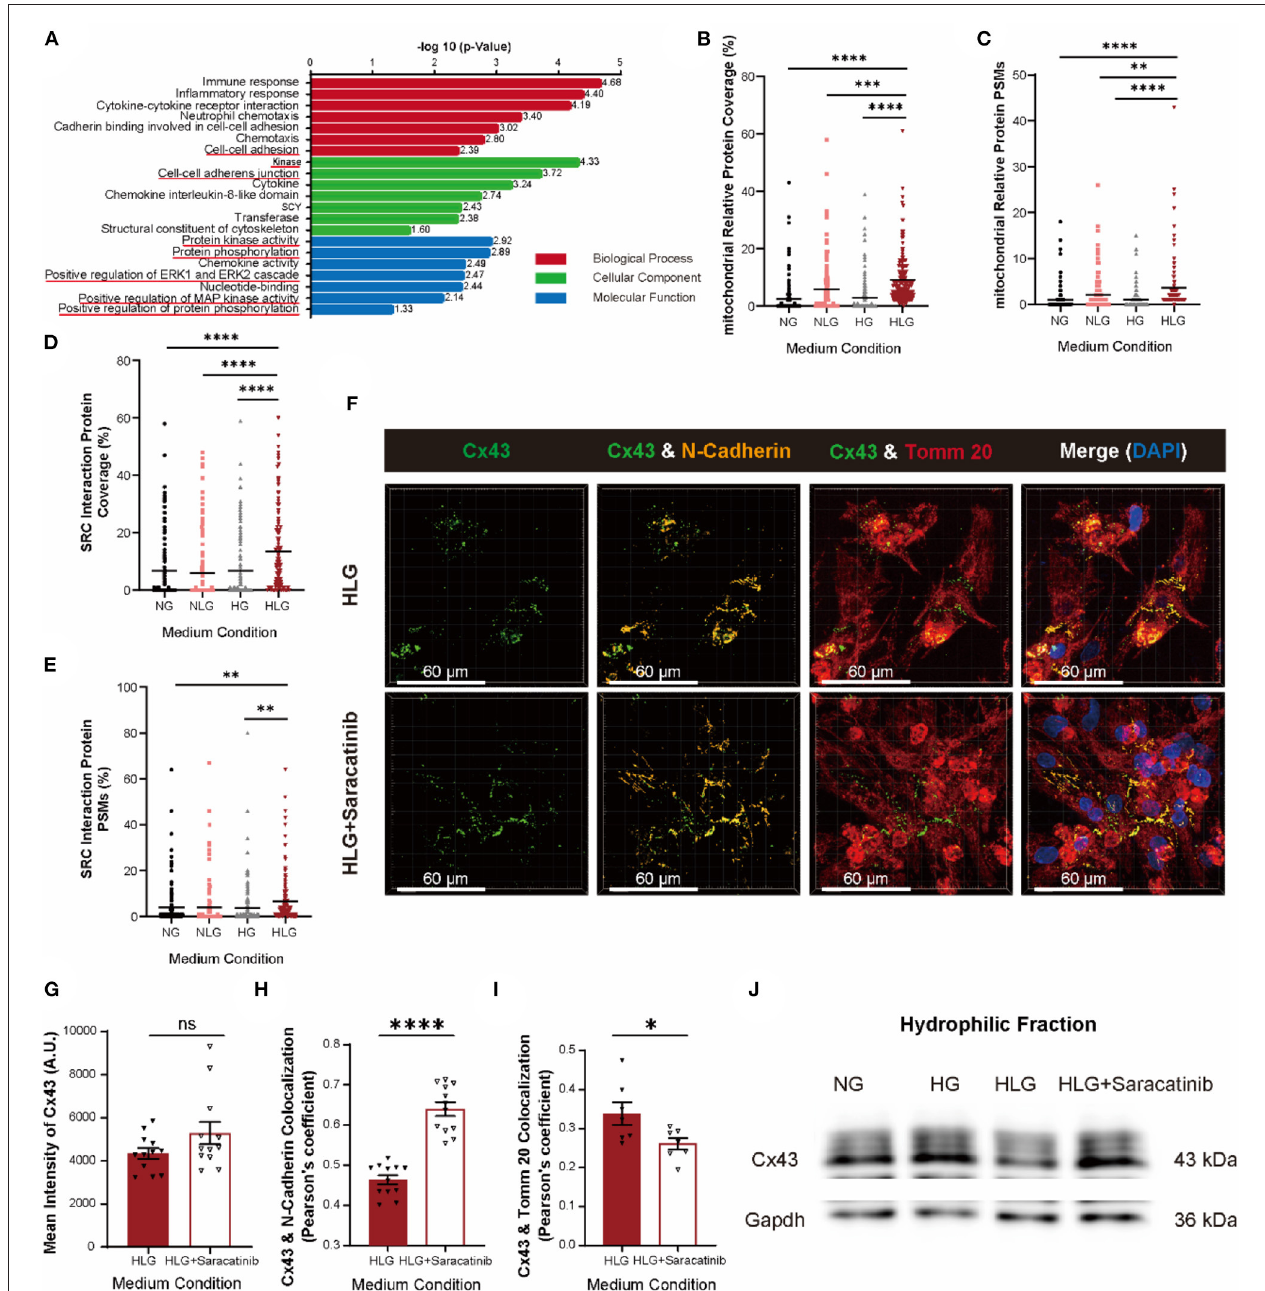
FIGURE 6 | Activation of Src protein regulates the entry of Cx43 into mitochondria. (A) The Gene Ontology pathway analysis of activated genes under HLG treatment. (B,C) Coverage and propensity score matching (PSM) analysis of mitochondria relative proteins ( n = 162 proteins per condition). (D,E) Coverage and PSMs analysis of Src-interacting proteins ( n = 131 proteins per condition). Data are shown as mean ± SEM. One-way ANOVA test was used. ** P < 0.01, *** P < 0.001, **** P < 0.0001. (F) Colocalization of Cx43 and Tomm20 in HLG and saracatinib-treated HLG NMVMs (scale bars, 60 µ m). (G–I) Analysis of mean intensity of Cx43 [ (G) , n = 12 per condition], Cx43, and N-cadherin [ (H) , n = 12 per condition], and colocalization of Cx43 and Tomm20 [ (I) , n = 7 per condition]. (J) Western blot of Cx43 in hydrophilic cell membrane of HLG and saracatinib-treated HLG NMVMs. Data are shown as mean ± SEM. The Student’s two-tailed t -test was used. * P < 0.05, **** P < 0.0001.